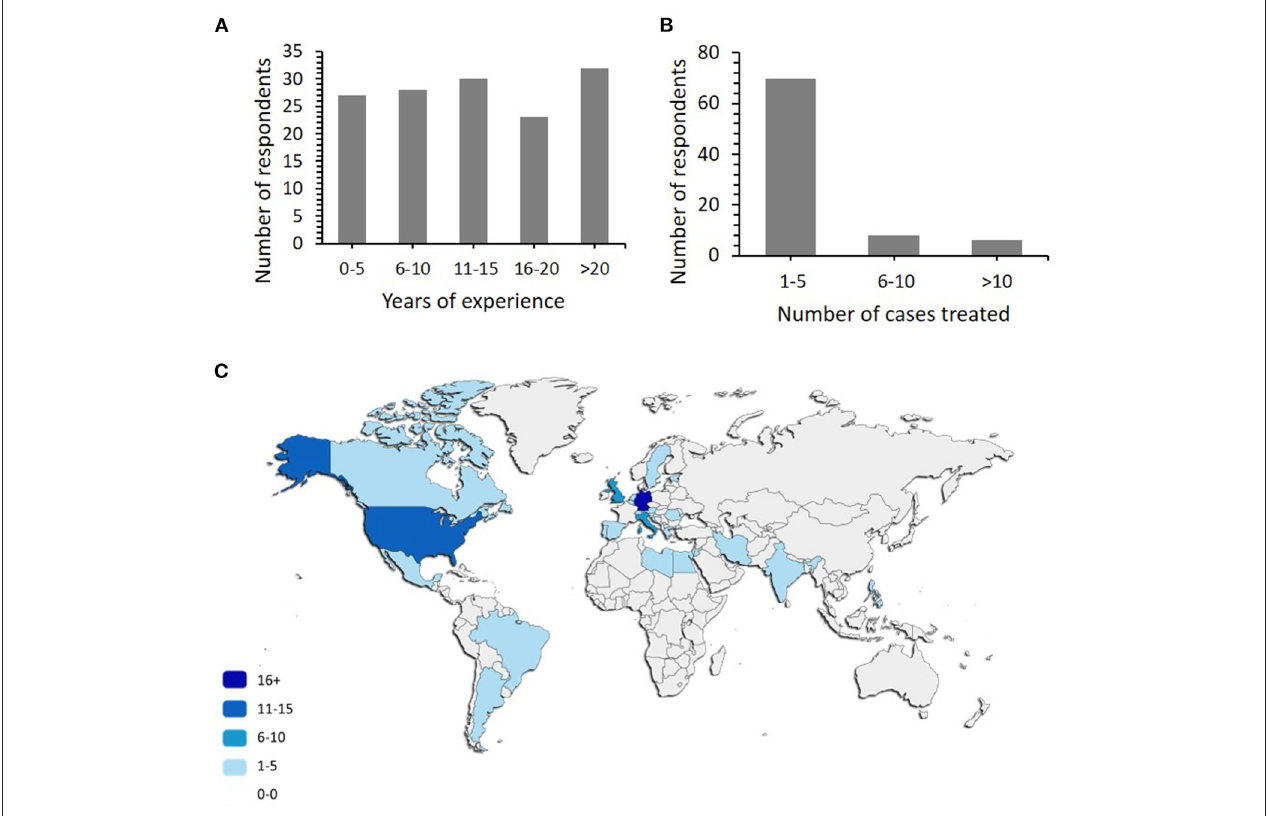
FIGURE 1 | Demographics of participants. (A) Portrays the number of years’ experience respondents have working in their speciality. (B) Number of patients with sv-cPACNS treated. To respondents answered treating more than 20 and 80 cases, respectively. (C) Map depicting the countries the respondents work in. This is done using a shading scale and legend. The darker the shading indicates a higher number or respondents from that country.